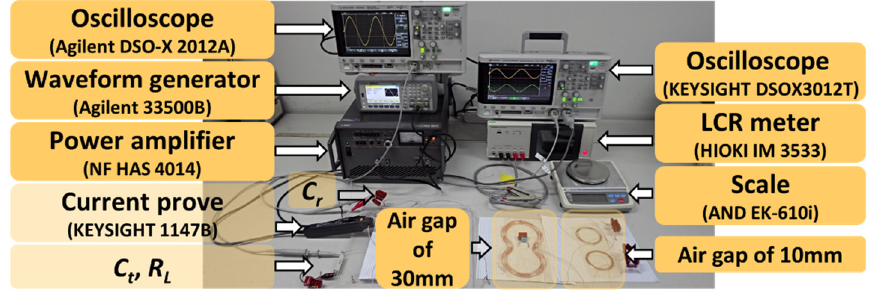
Figure 5. Experiment for validating the optimized S-M WPT systems with two receiver modules according to the 10 mm and 30 mm air gaps.